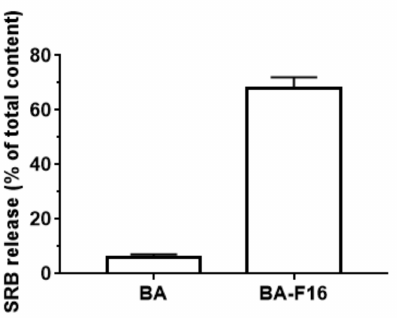
Figure 6. BA–F16 (1 µ M) but not BA (50 µ M) induces the release of the sulforodamine B dye from unilamellar lecithin liposomes. The incubation medium contained: 10 mM Tris-HCl (pH 7.5), 40 mM KCl, and 50 µ M EGTA. The results are presented as means ± SEM ( n = 5). To identify the cause of the increase in liposome membrane permeability, we evaluated the effects of BA and BA–F16 on the state of DPPC membranes using the fluorescent probe laurdan (Figure